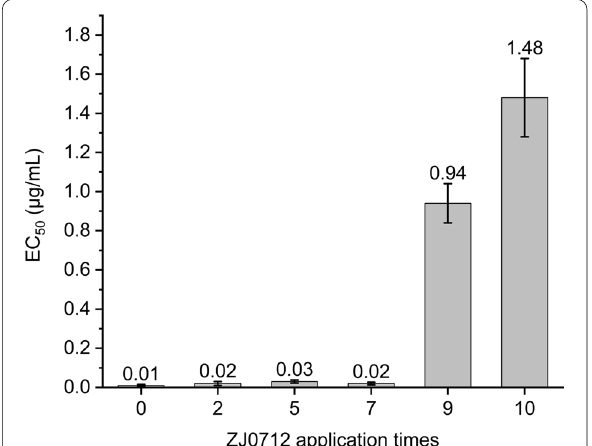
Fig. 1 Developing resistance to ZJ0712 in Podosphaera xanthii isolates during consecutive application of the fungicide on greenhouse-grown cucumber plants for two successive growing seasons